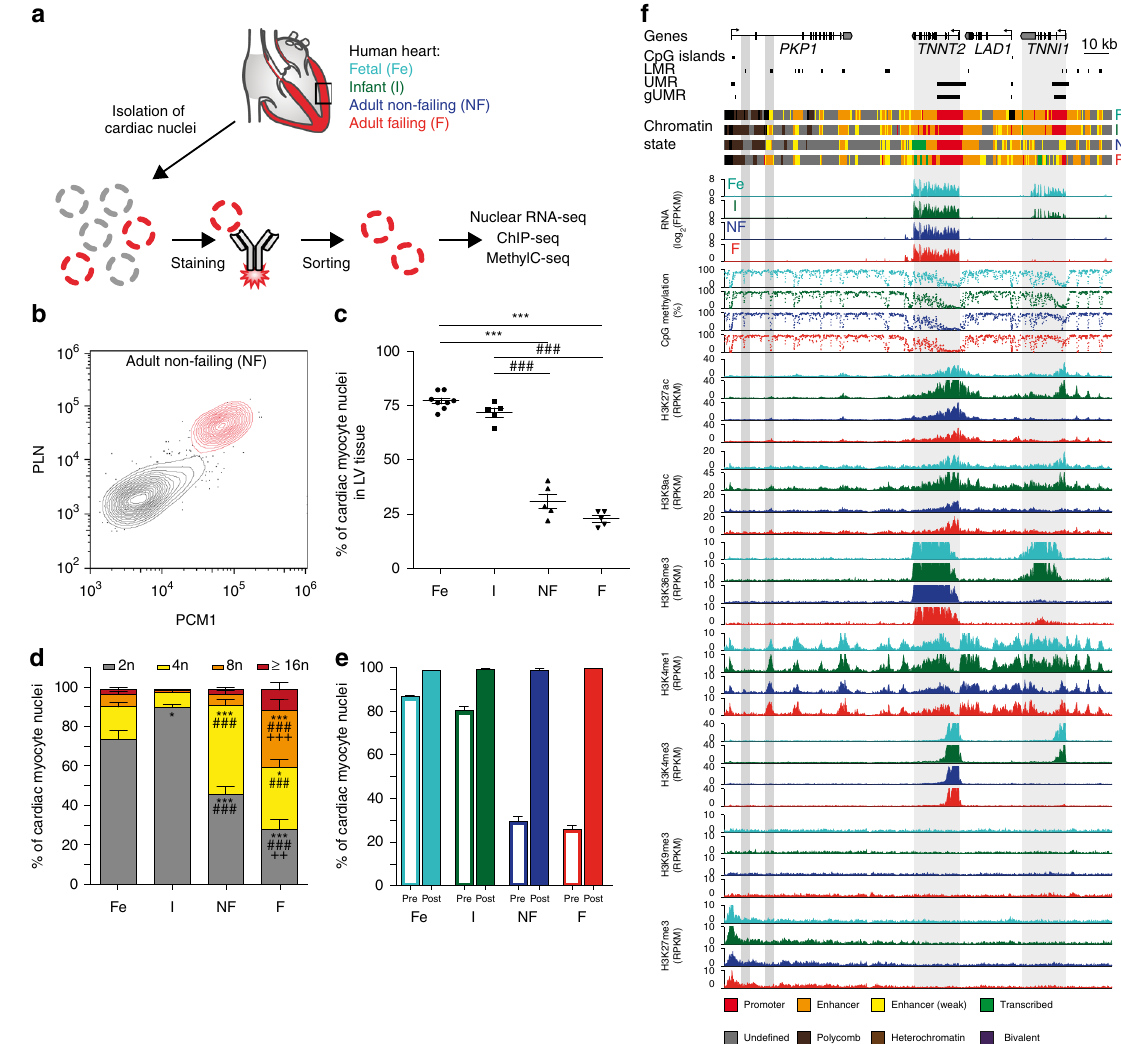
Fig. 1 Sorting and analysis of cardiac myocyte nuclei and representative epigenetic map. a Work fl ow for the isolation of human cardiac myocyte nuclei for epigenetic and transcriptomic analysis. b FACS analysis of nuclei isolated from adult non-failing left ventricular tissue (LV). Nuclei were stained with anti- pericentriolar material 1 (PCM1) and anti-phospholamban (PLN) antibodies to identify cardiac myocyte nuclei (red). c Proportion of cardiac myocyte nuclei in fetal (Fe, n = 8), infantile (I, n = 5), adult non-failing (NF, n = 5), and adult failing (F, n = 5) LV tissue (mean ± SEM). d Distribution of cardiac myocyte ploidy in fetal ( n = 8), infantile ( n = 5), non-failing ( n = 5), and failing ( n = 5) left ventricles (mean ± SEM). e Percentage of cardiac myocyte nuclei in LV tissue before sorting (pre, open columns) and cardiac myocyte nuclei purity after FACS sorting (post, n = 3, mean ± SEM). f Original traces of RNA expression, mCpG, and histone marks of the troponin I type 1 ( TNNI1 ) and troponin T type 2 ( TNNT2 ) gene region. CpG islands, low methylated regions (LMR), unmethylated regions (UMR), genic unmethylated regions (gUMR), and the chromatin state are annotated. Gray areas highlight differentially CpG- methylated regions and genes. Shown are data from n biological replicates: mCpG, n = 3 – 5; H3K27ac, H3K9ac, H3K36me3, H3K4me1, H3K4me3, H3K27me3, and H3K9me3, n = 3; RNA, n = 3 – 4; * vs. Fe, p < 0.05; ++ vs. NF, p < 0.01; ***vs. Fe, ### vs. I, +++ vs. NF, p < 0.001 by